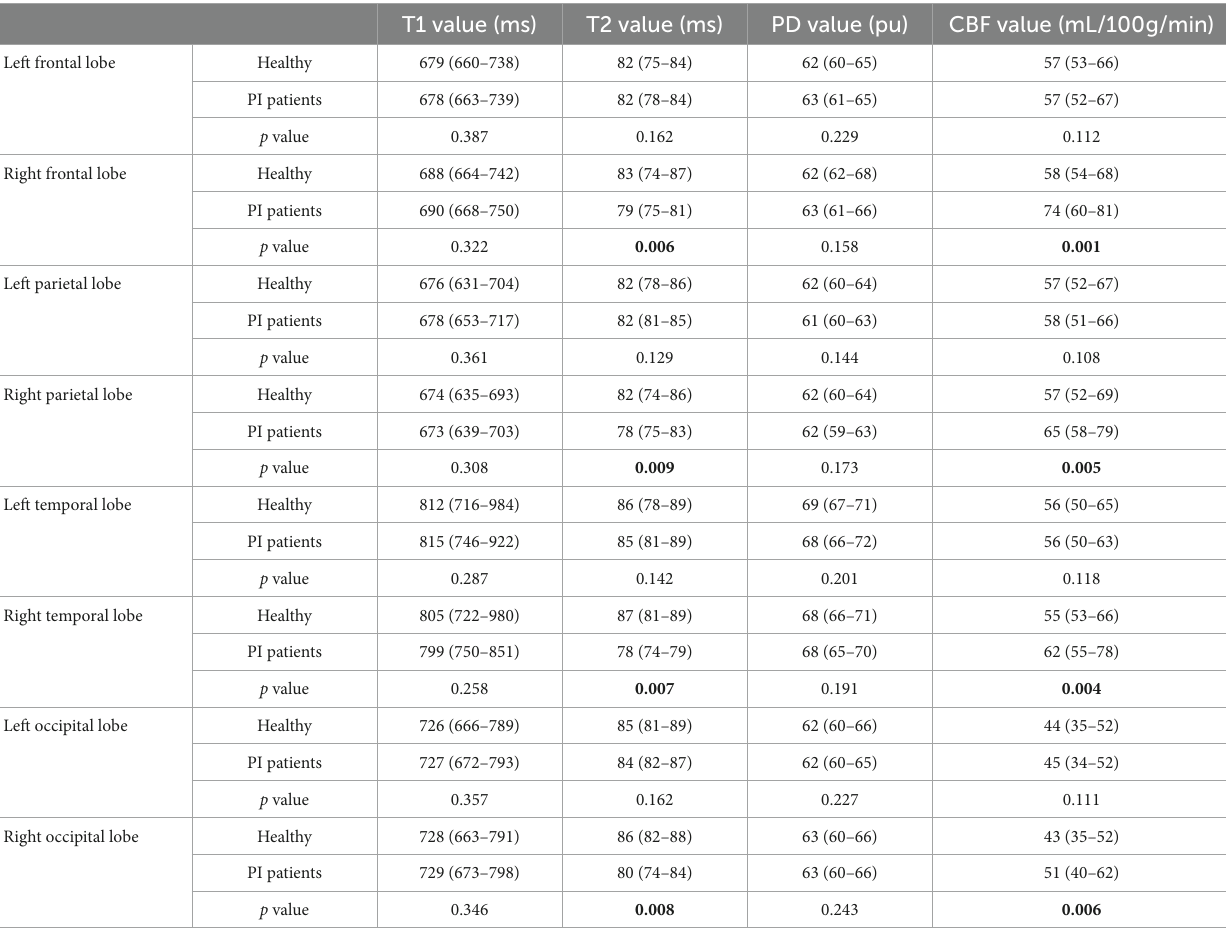
TABLE 2 The comparison of T1, T2, PD, and CBF values between healthy subjects and PI patients. T1 value